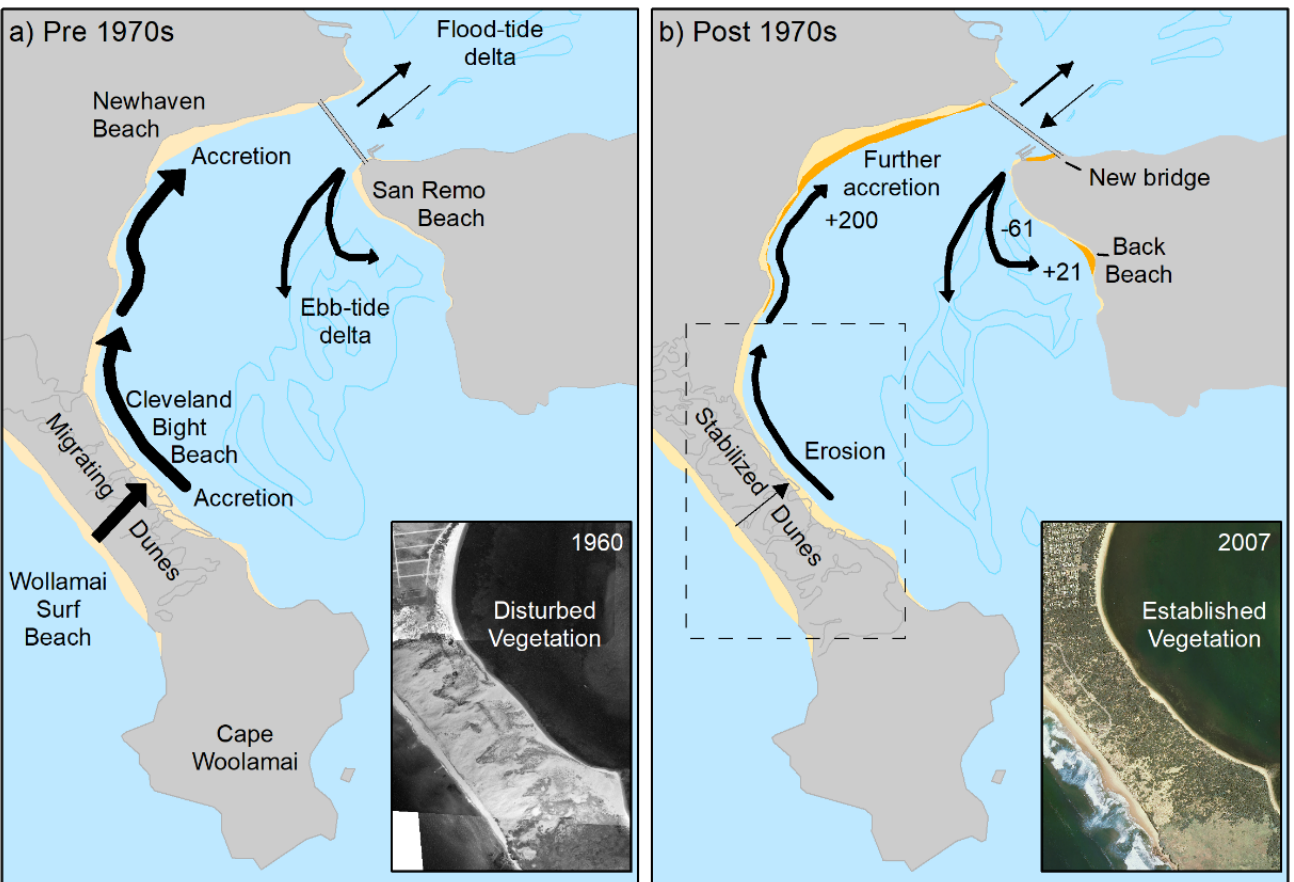
Figure 7. Preliminary sediment budget scheme for the Eastern Entrance before ( a ) and after ( b ) stabilisation of mobile dunes in the Woolamai isthmus. Arrow thickness indicates inferred volume of sediment transported. Accretion experienced from 1977 to 2007 is represented in orange, while numbers represent approximate volumes (in 1000 m 3 ). Aerial photograph inserts show disturbed and established vegetation following Marram grass planting in the dashed area.